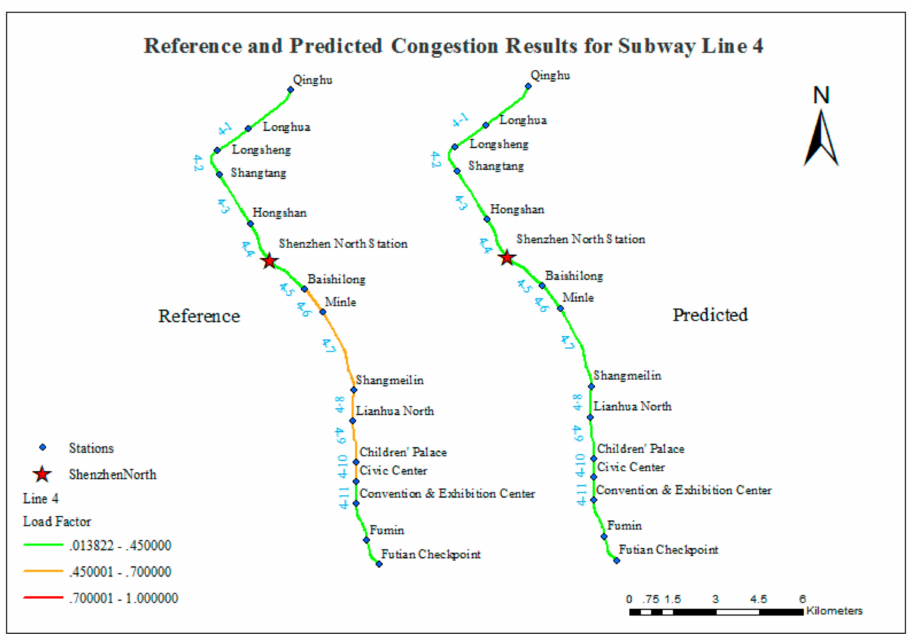
Figure 14. Comparison of reference and predicted congestion results for Line